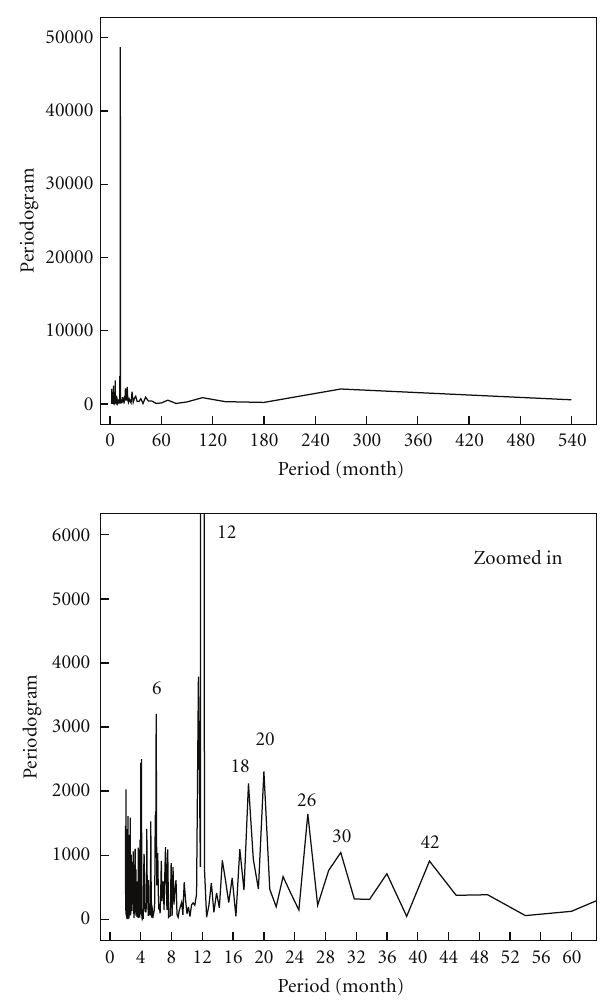
Figure 5: Periodogram for the monthly total rainfall data obtained from the weather station of Kuwait International Airport for the time duration from January 1965 to December 2009.